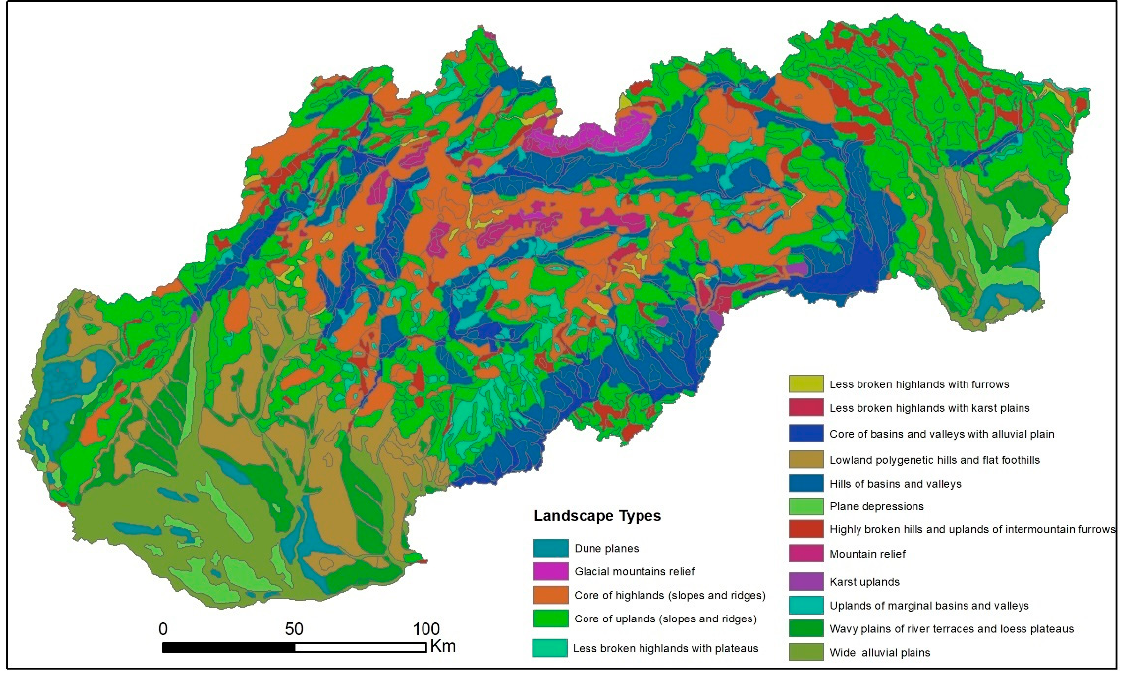
Figure 1. Map of Landscape types.